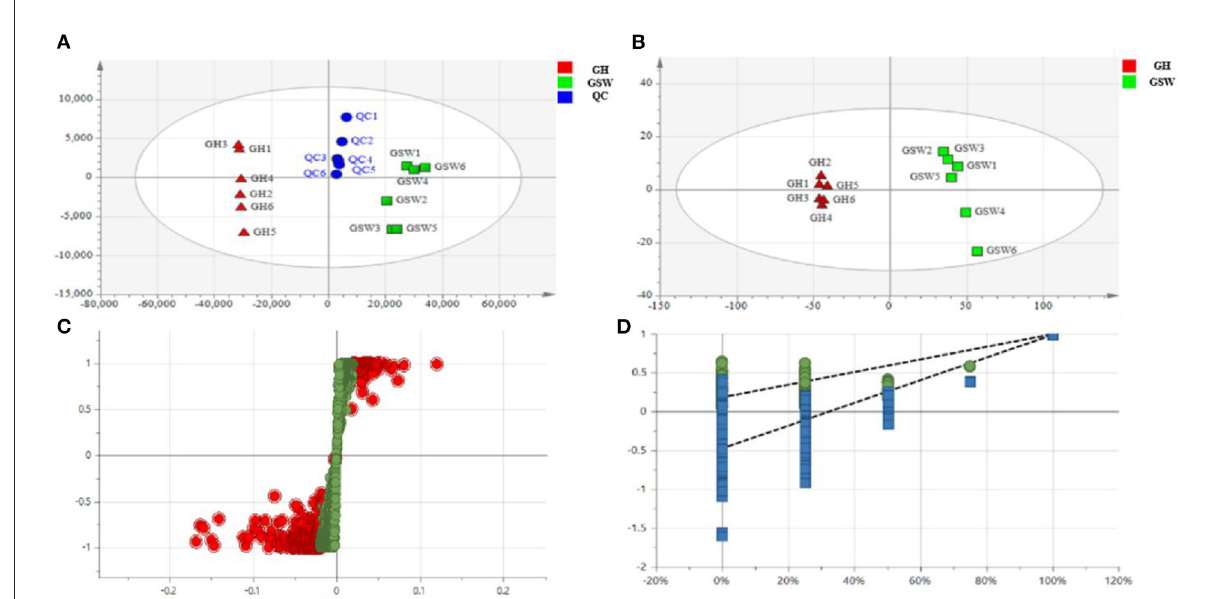
FIGURE9 Multivariate statistical analysis of UPLC-Q-Orbitrap-HRMS metabolic profiling data. Principal component analysis (PCA) score plot (A) , pair-wise orthogonal projections to latent structure discriminant analysis (OPLS-DA) score plot (B) , and OPLS-DA/permutation test/S-plot (C) derived from the UPLC-Q-Orbitrap-HRMS spectra of both groups of ginseng Huang jiu (GH1–GH6, red triangles) and ginseng-soaked wine (GSW1–GSW6, green square) in negative ion mode. Statistical validation of the OPLS-DA model by permutation testing (D) .